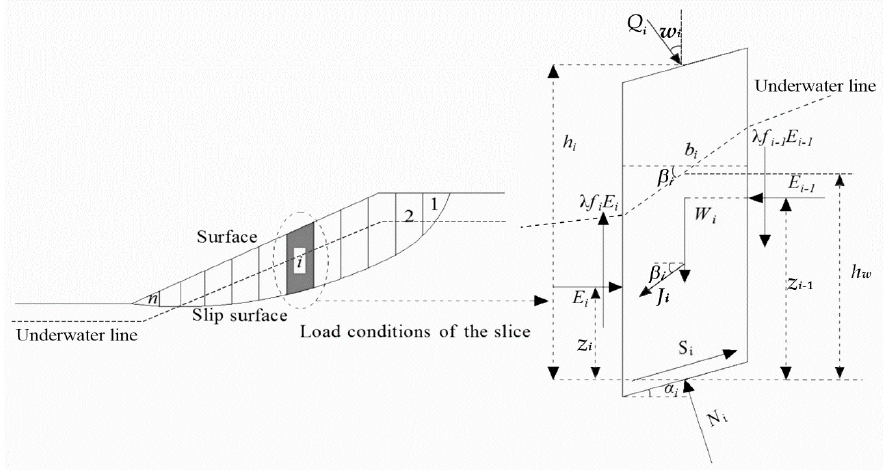
Figure 1. Morgenstern–Price (M–P) method calculation principle and model. (modified after Morgenstern et al. [31]).